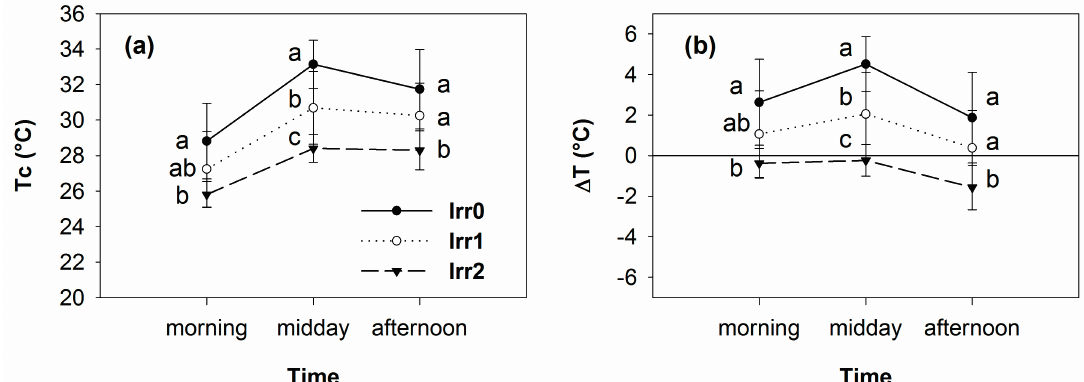
Figure 6. Time courses of average Tc (°C) ( a ) and Δ T ( b ) for the three water treatments. Vertical bars are ± one standard deviation. Tc and Δ T were analyzed with the non-parametric Kruskal–Wallis test. The results of the test are evidenced by letters on the plots. Statistically different ( p < 0.05) medians are designated with different